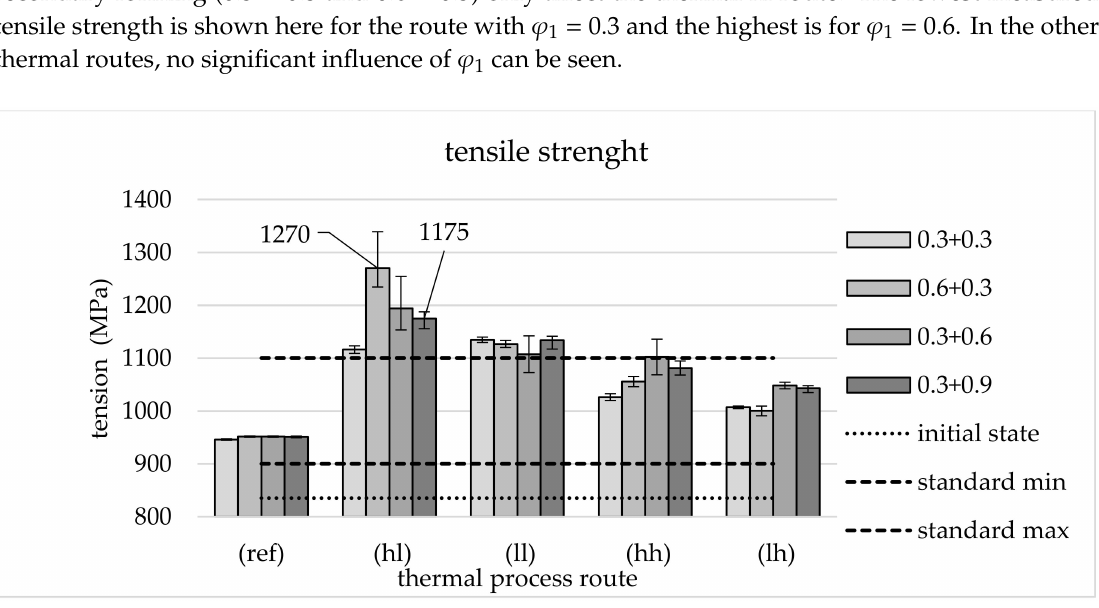
Figure 7. Tensile strength: Initial state, reference, di ff erent TMT routes and requirement of the standard, average of three tests and range of